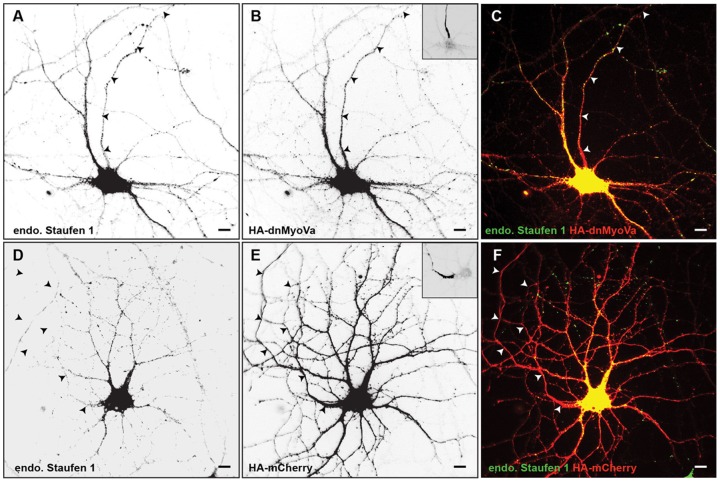
Myosin Va is necessary for somatodentritic targeting of endogenous Staufen1.
A. Endogenous Staufen 1 is present in the axon as well as in the soma and dendrites when co-expressed with HA-dnMyoVa (B), a dominant-negative variant of Myosin Va. C. Merge of endogenous Staufen 1 (green) and HA-dnMyoVa (red). D. Endogenous Staufen 1 is completely absent from the axonal compartment, but is expressed in the somatodendritic compartment of cortical neurons, expressing HA-mCherry (E). F. Merge of endogenous Staufen 1 (green) and HA-mCherry (red). Arrowheads point to the axon. Scale bars represent 10 μm. Insets show staining for Ankyrin G, a marker for the axon initial segment.